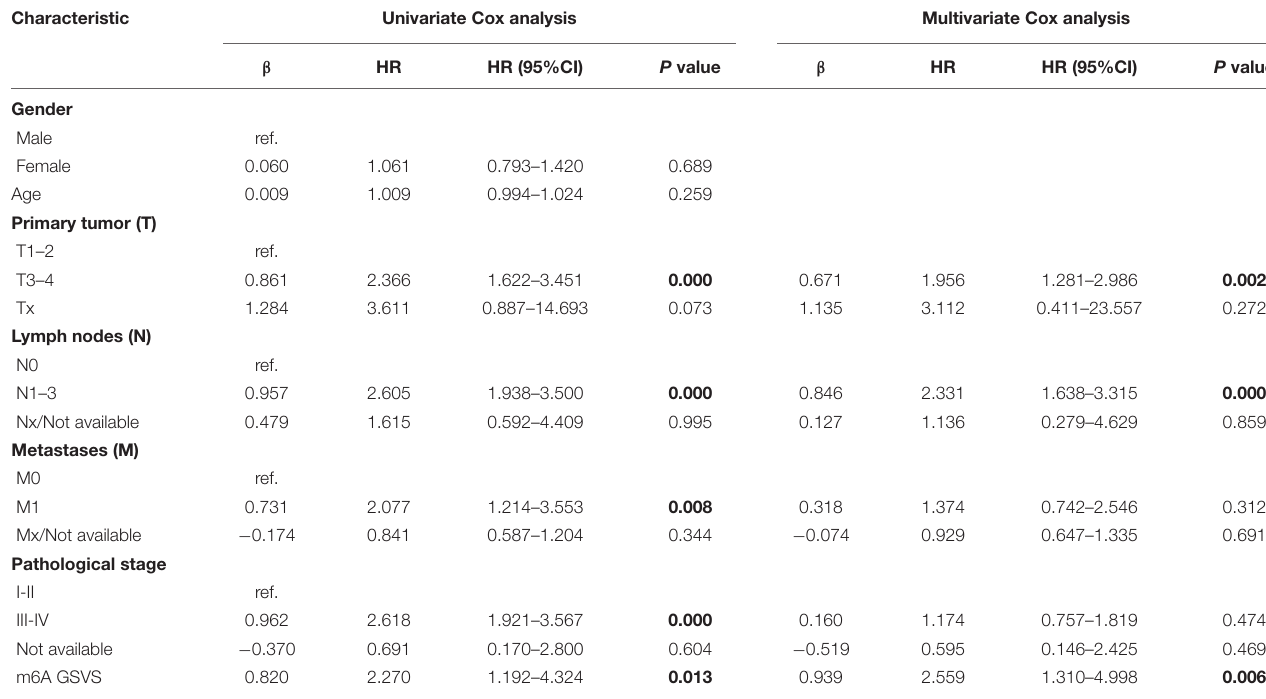
TABLE 1 | Univariate and multivariate Cox analyses of the m6A-GSVS and routine clinicopathologic characteristics in patients with lung adenocarcinomas. Characteristic Univariate Cox analysis Multivariate Cox